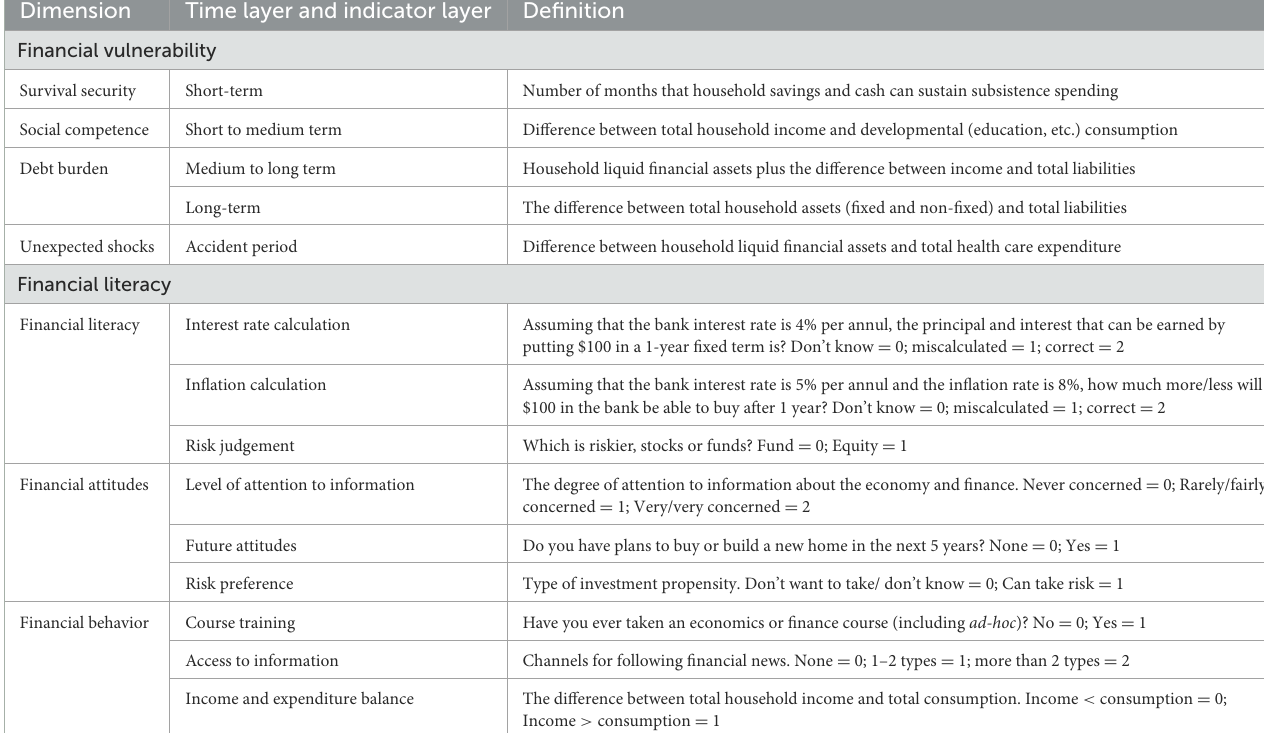
TABLE 1 Construction of financial vulnerability and financial literacy index system.